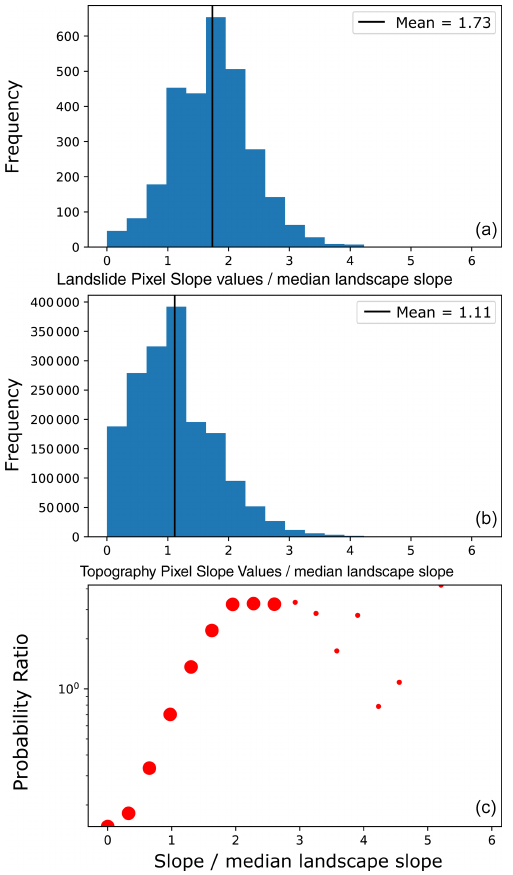
Figure 3. Example of landslide:topography ratio comparison for landslides in Zimbabwe triggered by Cyclone Idai. This shows the distribution of values for landslides (a) and topography (b) for slope. The lower part of the figure (c) shows the relative ratio of the two distributions for the parameter. The black lines in (a) and (b) illustrate the mean value of the data. In the lower figure (c) , the size of the points depends on whether the difference between landslide and topography exceeds the calculated confidence inter- val for that bin interval; larger points indicate significant deviation ( p > 0 . 95), and small points indicate the difference is not signifi- cant at that probability